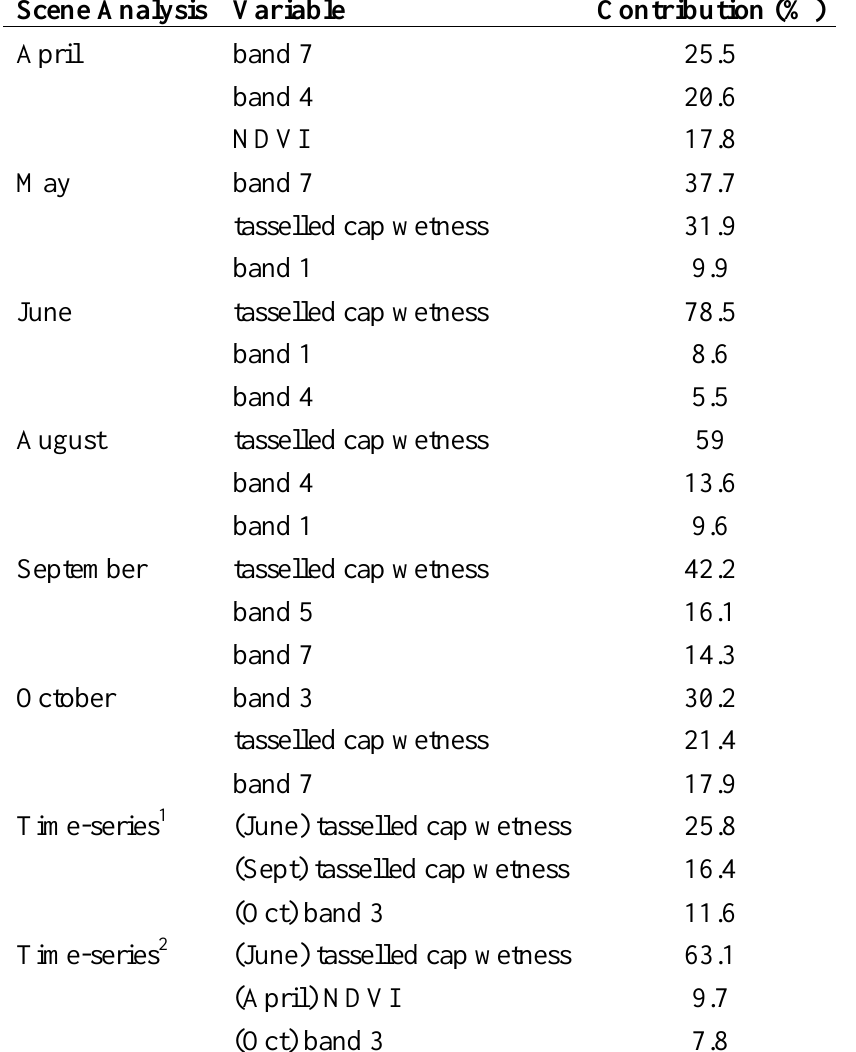
Table 2. The predictive contributions of the top three variables for each model generated from